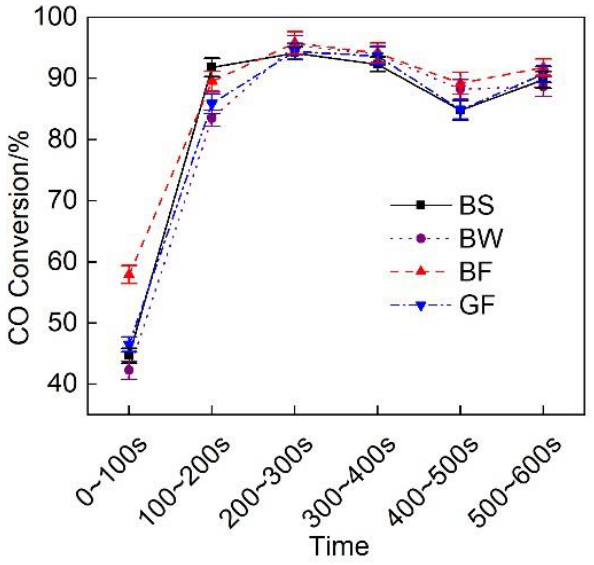
Figure 14. CO conversion efficiency at each substage of the initial idling stage of the different exhaust pipe covering schemes.